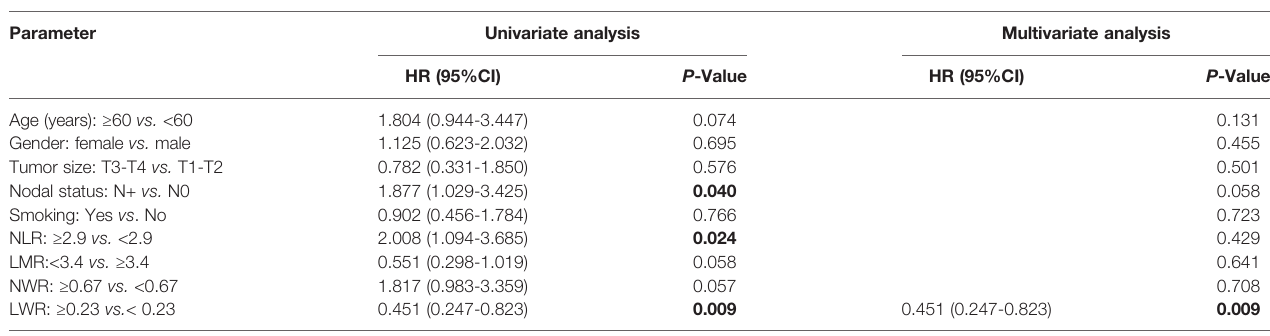
TABLE 5 | Univariate and multivariate analysis for